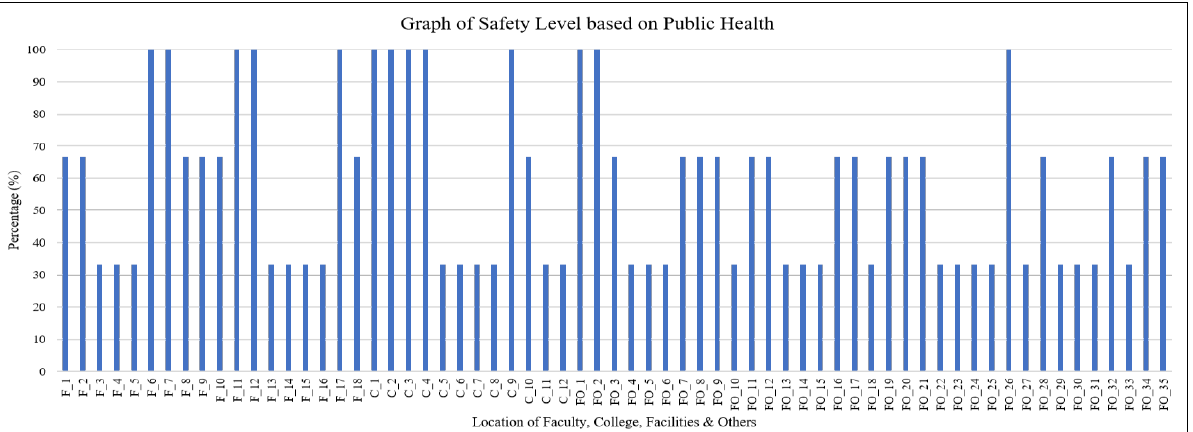
Figure 4. Result of analysis for Environment Indicator.